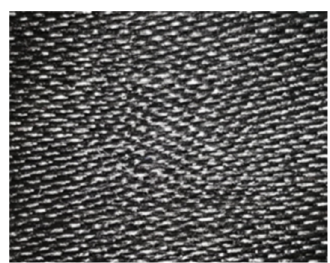
Figure 3. The surface morphology of the specimen.